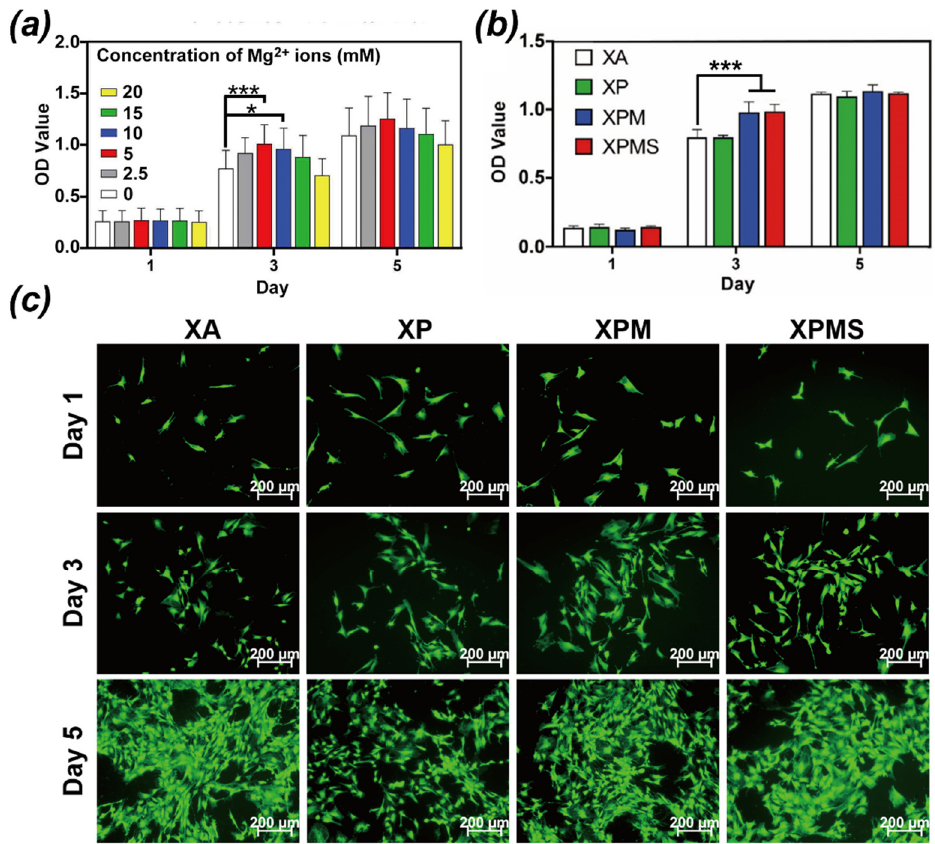
Figure 3. In vitro effect of Mg 2+ loaded hydrogels on BMSCs proliferation; ( a ) The proliferation of BMSCs treated with different concentrations of Mg 2+ after one, three, and five days; ( b ) The proliferation of BMSCs in different hydrogel extractions after one, three, and five days; ( c ) Representative fluorescence images of BMSCs in different hydrogels extractions evaluated by Live/Dead staining. * p < 0.05, and *** p < 0.001.